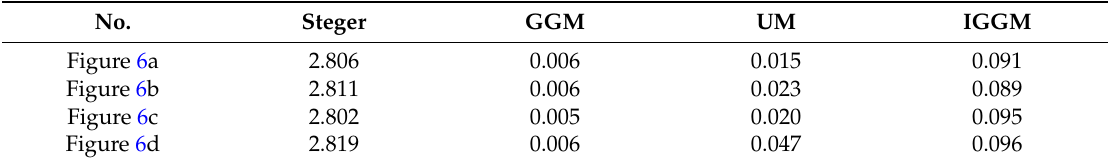
Table 2. Average run time for the center extraction